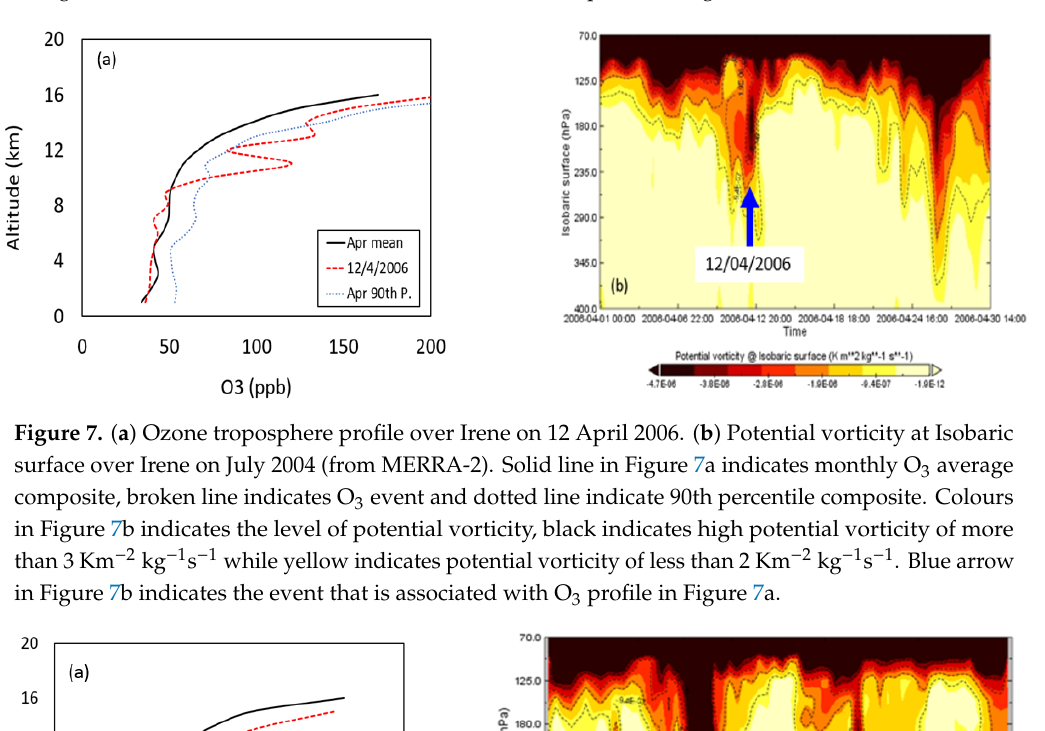
Figure 6. ( a ) Ozone troposphere profile over Irene on 26 August 2005. ( b ) Potential vorticity at Isobaric surface over Irene on July 2004 (from MERRA-2). Solid line in Figure 6a indicates monthly O 3 average composite, broken line indicates O 3 event and dotted line indicate 90th percentile composite. Colours in Figure 6b indicates the level of potential vorticity, black indicates high potential vorticity of more than 3 Km − 2 kg − 1 s − 1 while yellow indicates potential vorticity of less than 2 Km − 2 kg − 1 s − 1 . Blue arrow in Figure 6b indicates the event that is associated with O 3 profile in Figure 6a.